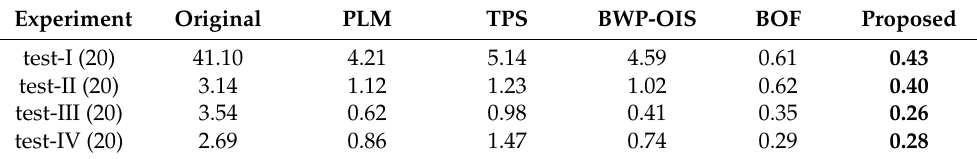
without being affected by the LULC changes in the flat-terrain region, and the proposed algorithm copes with the LULC changes in the complex-terrain region well. Table 2. RMSE ( ↓ ) of different algorithms in the experiments (by pixels). Experiment